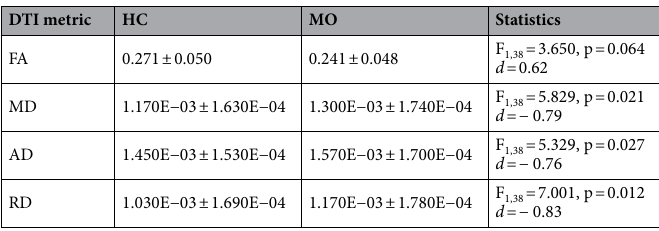
and univariate statistics of DTI metrics of the anterior and posterior part of the left and right hypothalamus in HC and MO are reported. fMRI resting-state networks. The twenty ICs were grouped into the following ten large-scale networks based on their spatial patterns (Fig. 1): Cerebellum (IC1—Cb); Auditory Network (IC2—AN); Fronto-Parietal Network (IC3—right FPN and IC23—Left FPN); Dorsal Attention System (IC6—left DAS and IC17—right DAS); Sensory Motor Network (IC7, IC8, IC33); Salience Network (IC 10—anterior part of SN (aSN) and IC19); Visual Network (IC11—Primary visual (PV) and IC 24—lateral visual (LVN)); Default Mode Network (DMN— IC15, IC20, IC28, and IC31); Precuneous (IC25 and IC27); Language Network (LN—IC 26).